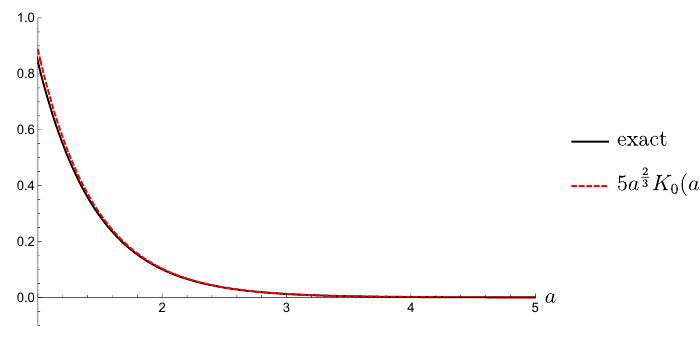
Figure 15 . Numerical evaluation of eq.